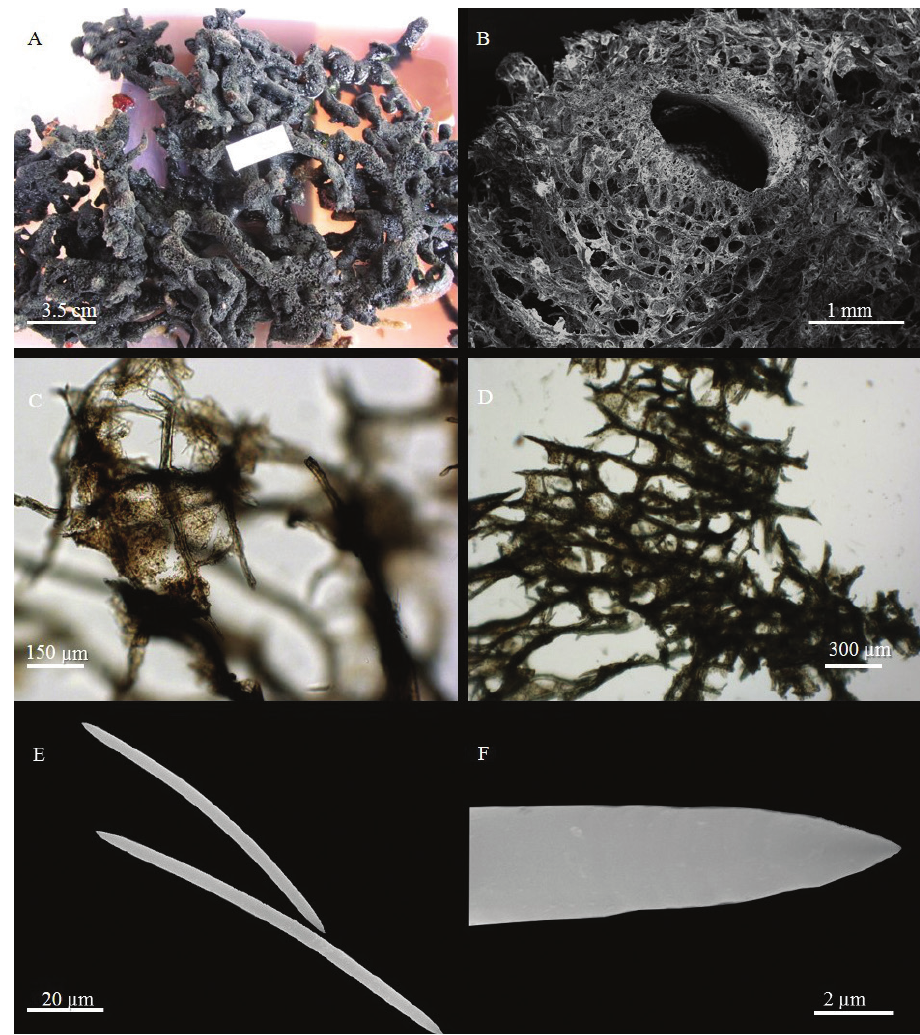
Figure 7. Amphimedon anastomosa sp. n. A The holotype just after collection B Sponge surface with the round opening of a symbiotic barnacle C ectosomal skeleton D choanosomal skeleton E oxeas F magni- fication of an oxea